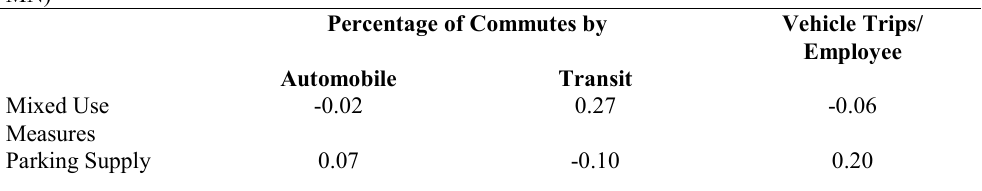
Table 5. Elasticities Between Travel Demand and Mixed Uses: Six U.S. Activity